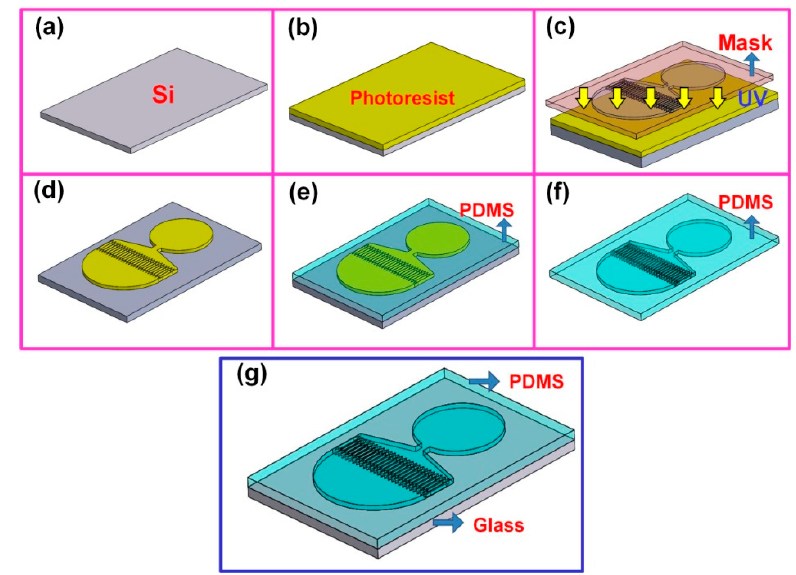
Figure 2. Schematic of the fabrication process of the microfluidic device: ( a ) wafer cleaning, ( b ) photoresist coating, ( c ) exposure, ( d ) development, ( e ) casting, ( f ) demolding, and ( g ) packaging.